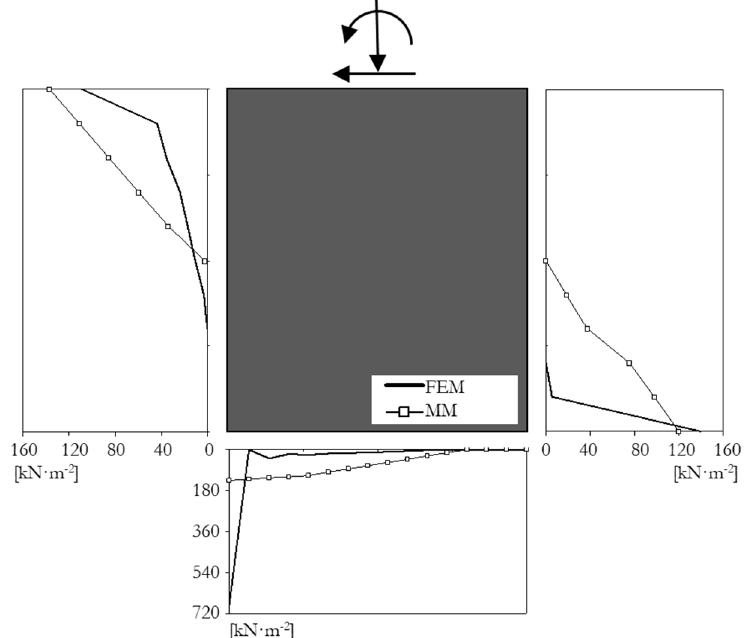
Figure 26. Pressure in the plane of symmetry, expressed in kN · m − 2 and determined by the Finite Element Model and the Matrix Model, on the walls and base of the footing due to the simultaneous application of axial, shear and moment stresses.